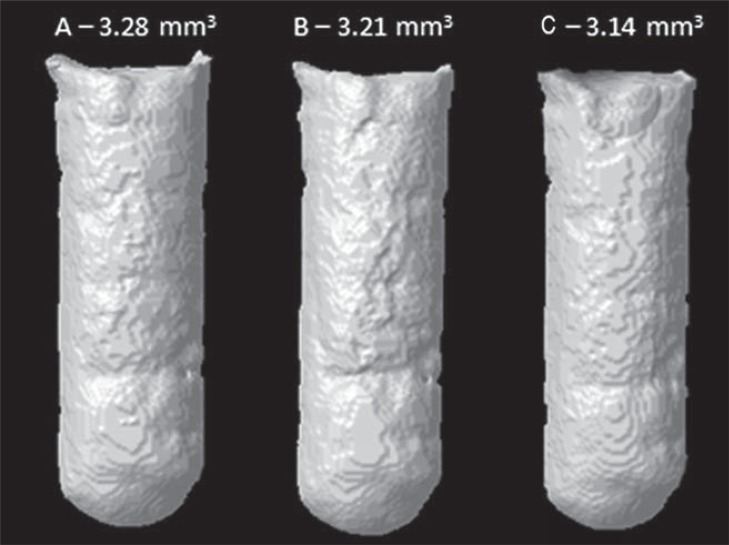
3D model from CTVol software representing the cavity filled with Biodentine in test periods: (A) Initial, (B) after 7 and (C) 30 days of immersion in distilled water. Volumetric filling values in mm3